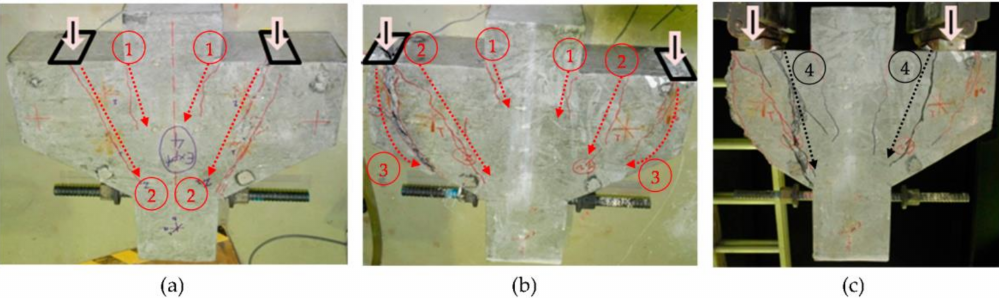
Figure 7. Fracture patterns for corbels of the first series: ( a ) D-C, ( b ) PE-C, and ( c )